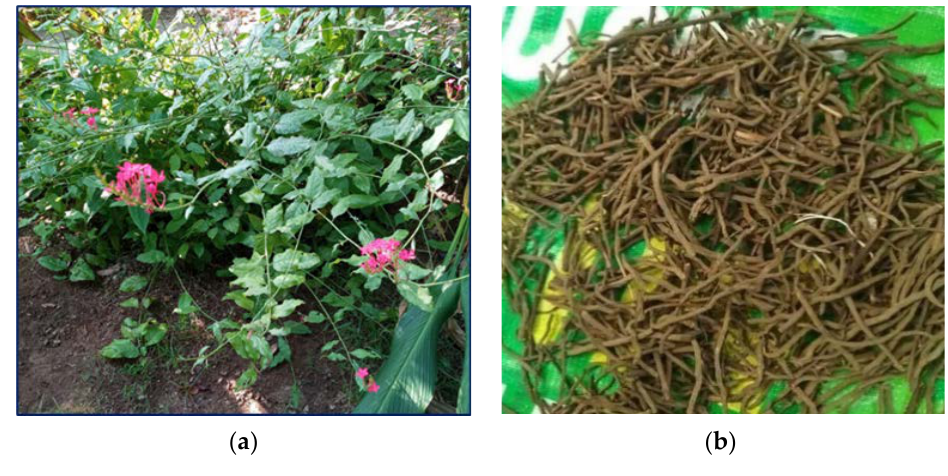
Figure 1. Plumbago rosea : ( a ) whole plant, ( b ) stems. Lepidium sativum L. (cress) was used for testing the inhibitory effects of allelochemical substances on germination because of its wide range, well-known growth behaviors, and stable germination